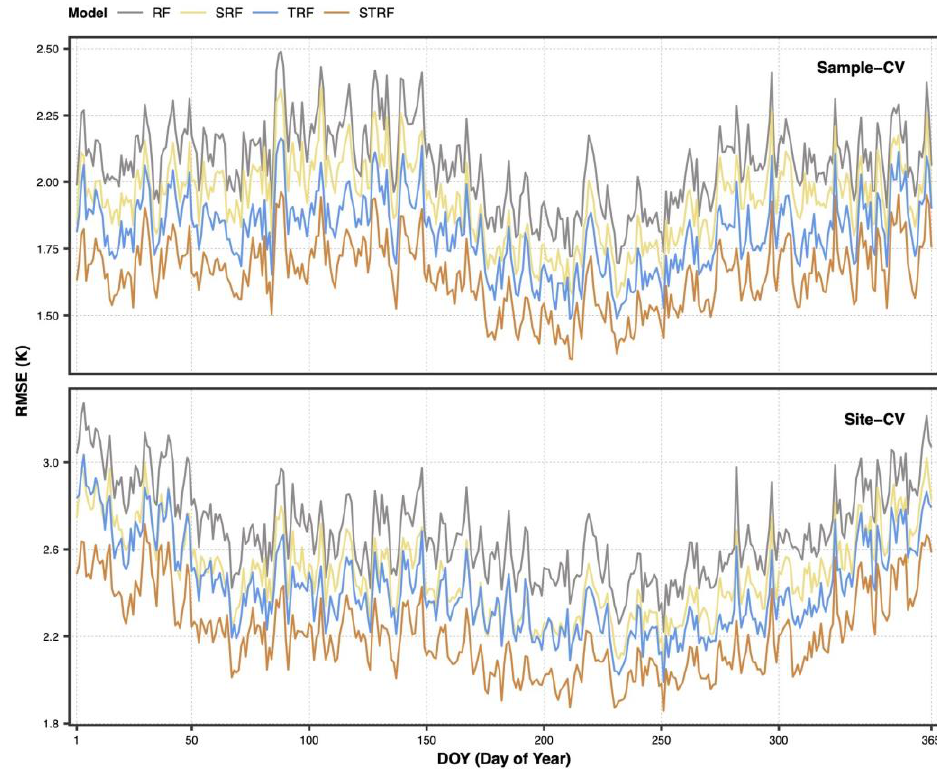
Figure 5. Daily variation in predictive performance (RMSE) of the STRF model for site-based